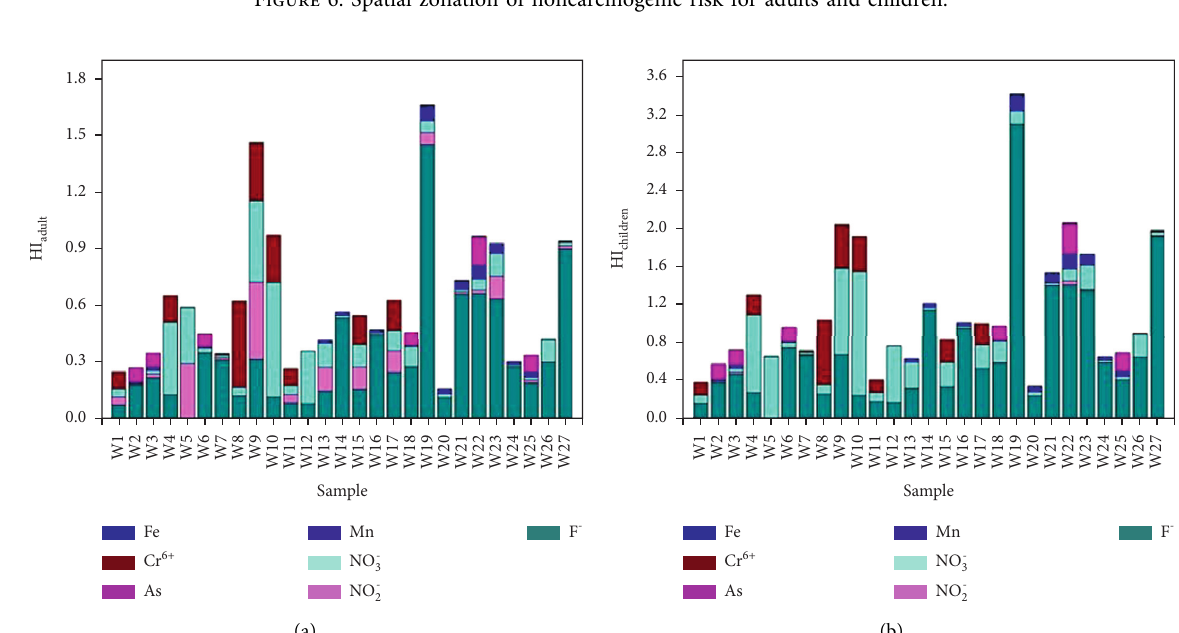
Figure 7: Noncarcinogenic risk of the groundwater samples for adults and